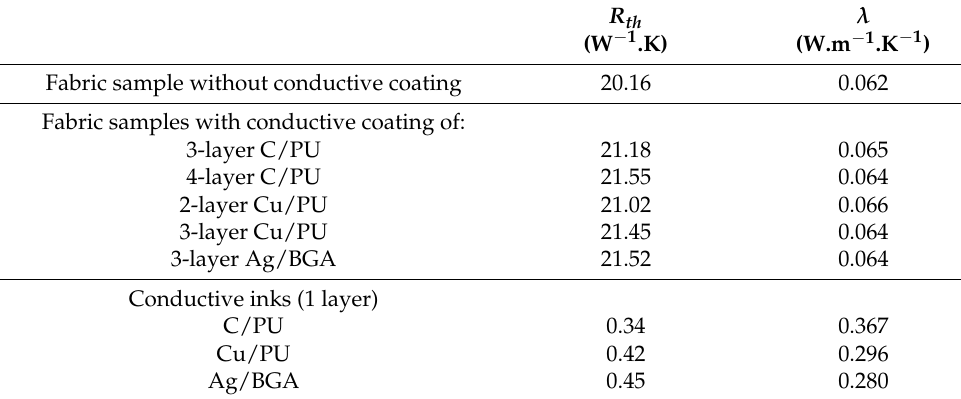
Table 7. Measured thermal conductivity of coated and neat fabric samples. The resistance and the conductivity of the conductive coatings were deduced from Equations (8) and (9). R th λ (W − 1 .K) (W.m − 1 .K − 1 ) Fabric sample without conductive coating 20.16 0.062 Fabric samples with conductive coating of: 3-layer C/PU